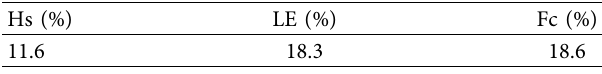
Table 2: Percentage of turbulent fux data that required